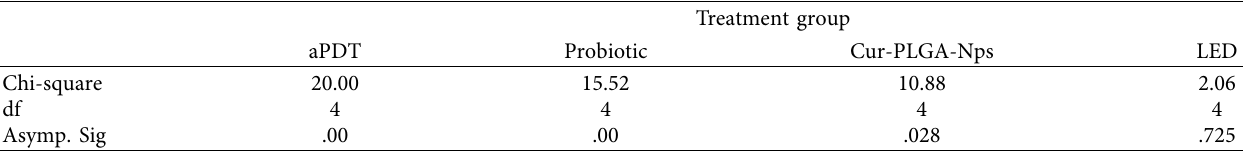
Table 2: Results from comparisons of CFU/mL of S. mutans between the four treatment groups through the five subsequent measurement time points based on Friedman test.